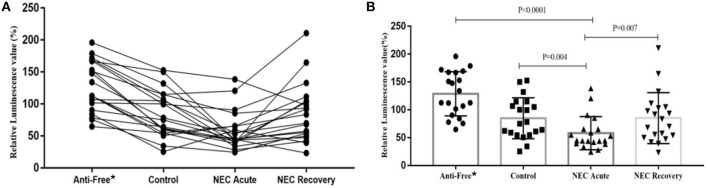
The relative biofluorescence values of AI-2 in feces from each group. (A) Bar graph of the relative biofluorescence values of AI-2 in feces and (B) Line graph of the relative biofluorescence values of AI-2 in feces. *Anti-free, antibiotic-free group.